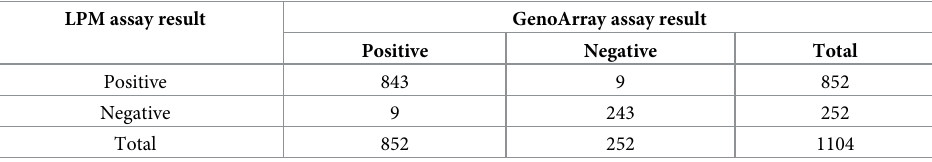
Table 3. Comparison of results for the overall detection of HPV DNA by the two